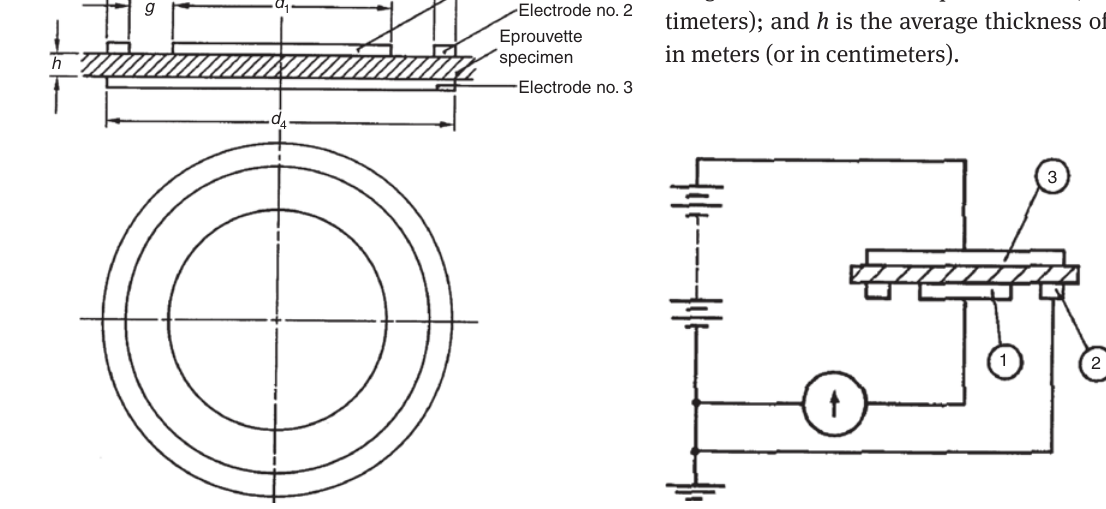
Figure 5 Arrangement of electrodes [19].